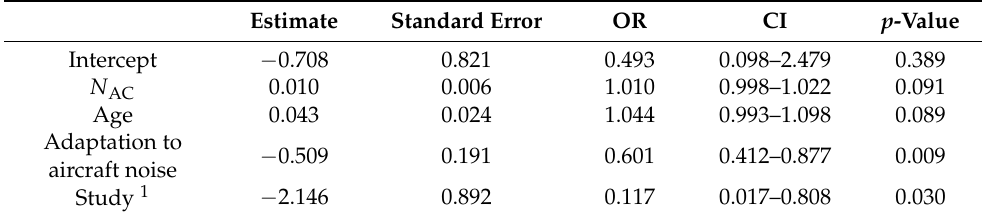
Table 6. Logistic regression model LR4 with random effects for the prediction of aircraft noise- induced short-term annoyance at night measured in the children’s and STRAIN (adults’) studies, with N AC during time in bed, age and the adaptation to aircraft noise as independent variables (AIC = 1349).